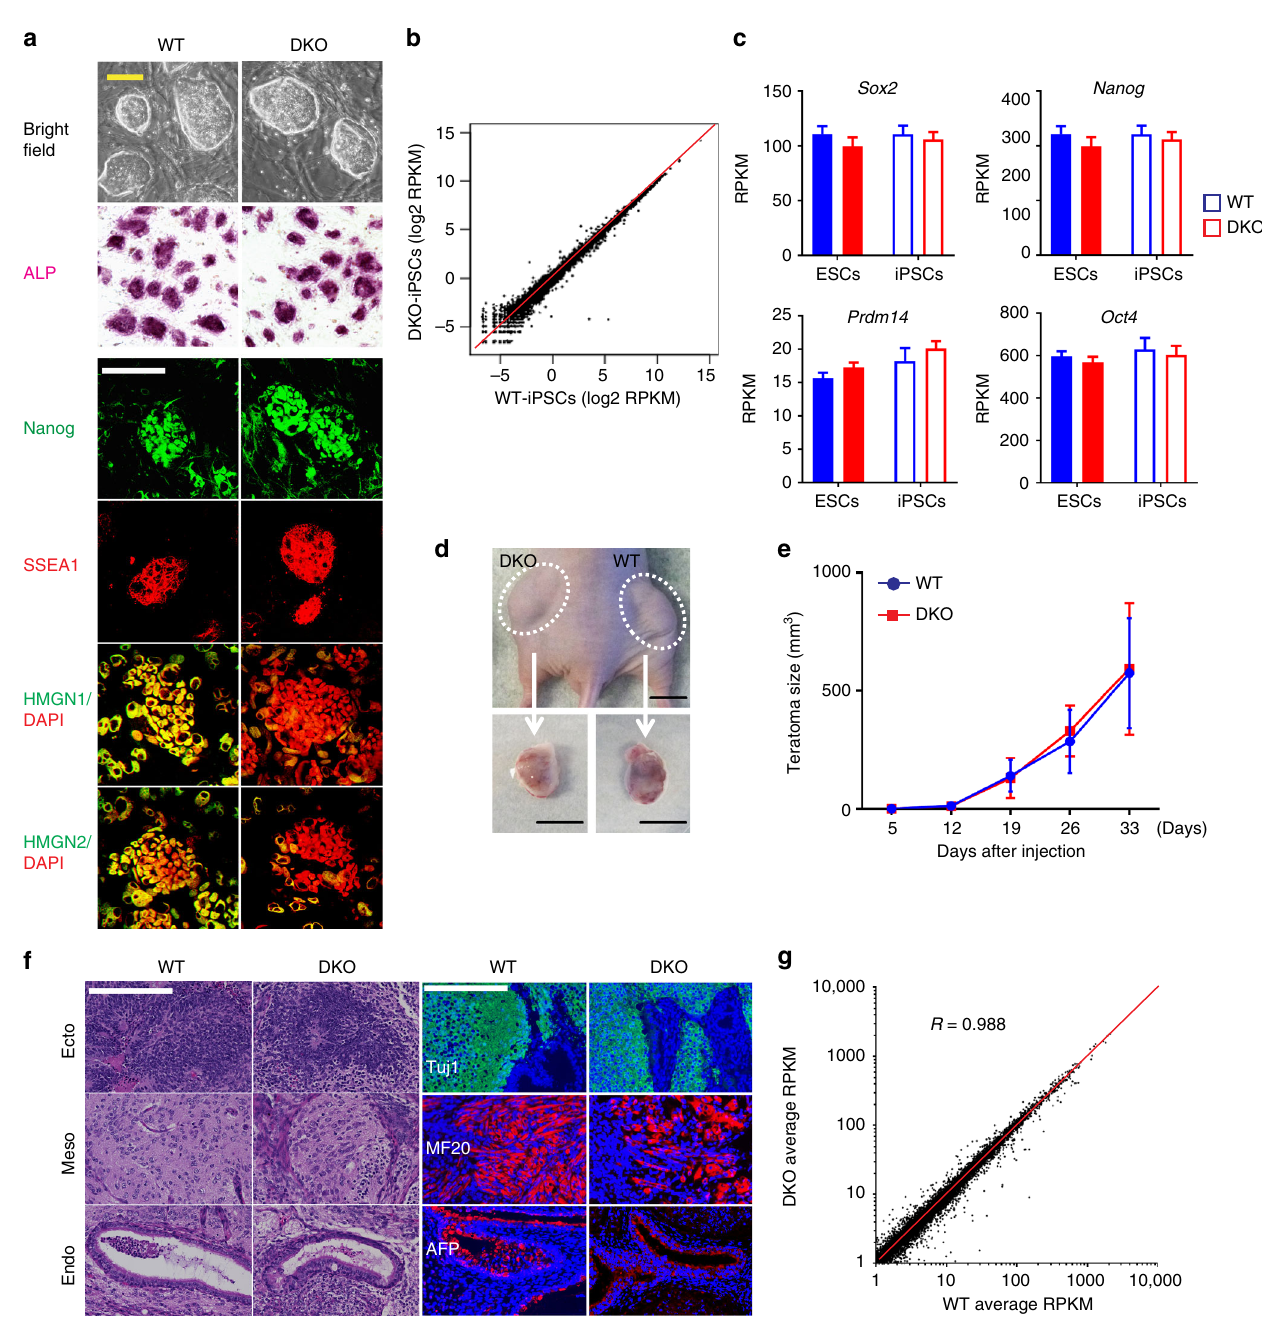
Fig. 5 HMGN depleted iPSCs maintain pluripotency and differentiation potential. a Characterization of iPSCs colonies generated from WT and DKO MEFs. ALP: alkaline phosphatase assay; four bottom rows: immuno fl uorescence analyses of the indicated targets. DAPI visualizes DNA. Scale bar: 100 μ m. b Scatter plot showing correlation between gene expression levels of WT and DKO iPSCs (average of 3 biological replicates). c Expression of select pluripotency markers in WT and DKO ESCs and in iPSCs (data was obtained from 3 biological replicates, and bar graph represents mean ± SD). d Teratomas derived from WT and DKO iPSCs injected into opposite fl anks of nude mice. Scale bar: 1 cm. e Equal growth rate of teratomas derived from WT and DKO iPSCs (data was obtained from 18 replicates; error bars are mean ± SD). f Histological analyses of teratoma sections derived by injecting WT and DKO iPSCs into opposite fl anks of nude mice. The three germ layers are identi fi ed by morphology after H&E staining (left) and by immuno fl uorescence with the indicated antibodies (right). Scale bar: 200 μ m. g Scatter plot showing correlation between gene expression in teratomas derived from WT and DKO iPSCs (average of 6 biological replicates for each